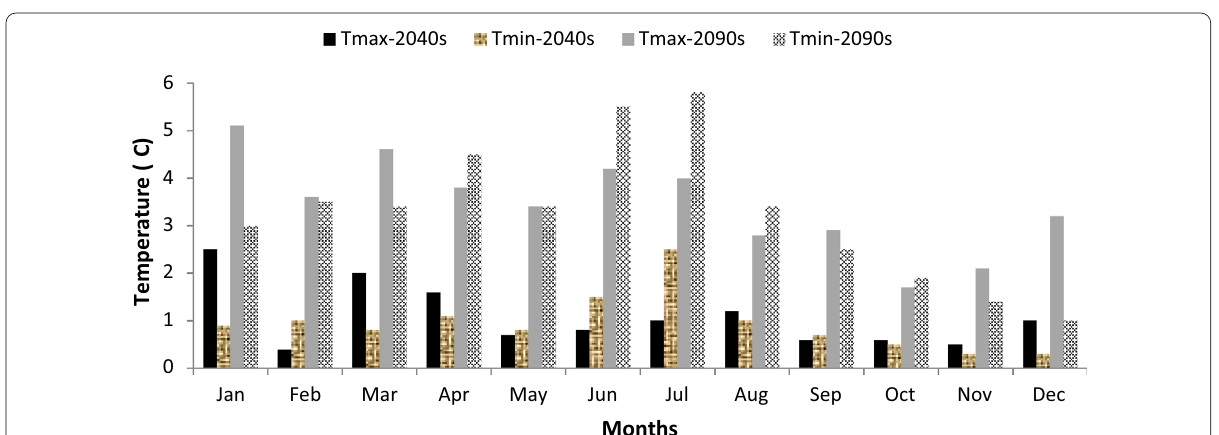
Fig. 7 Future mean monthly max. and min. temperature fluxes compared to base period